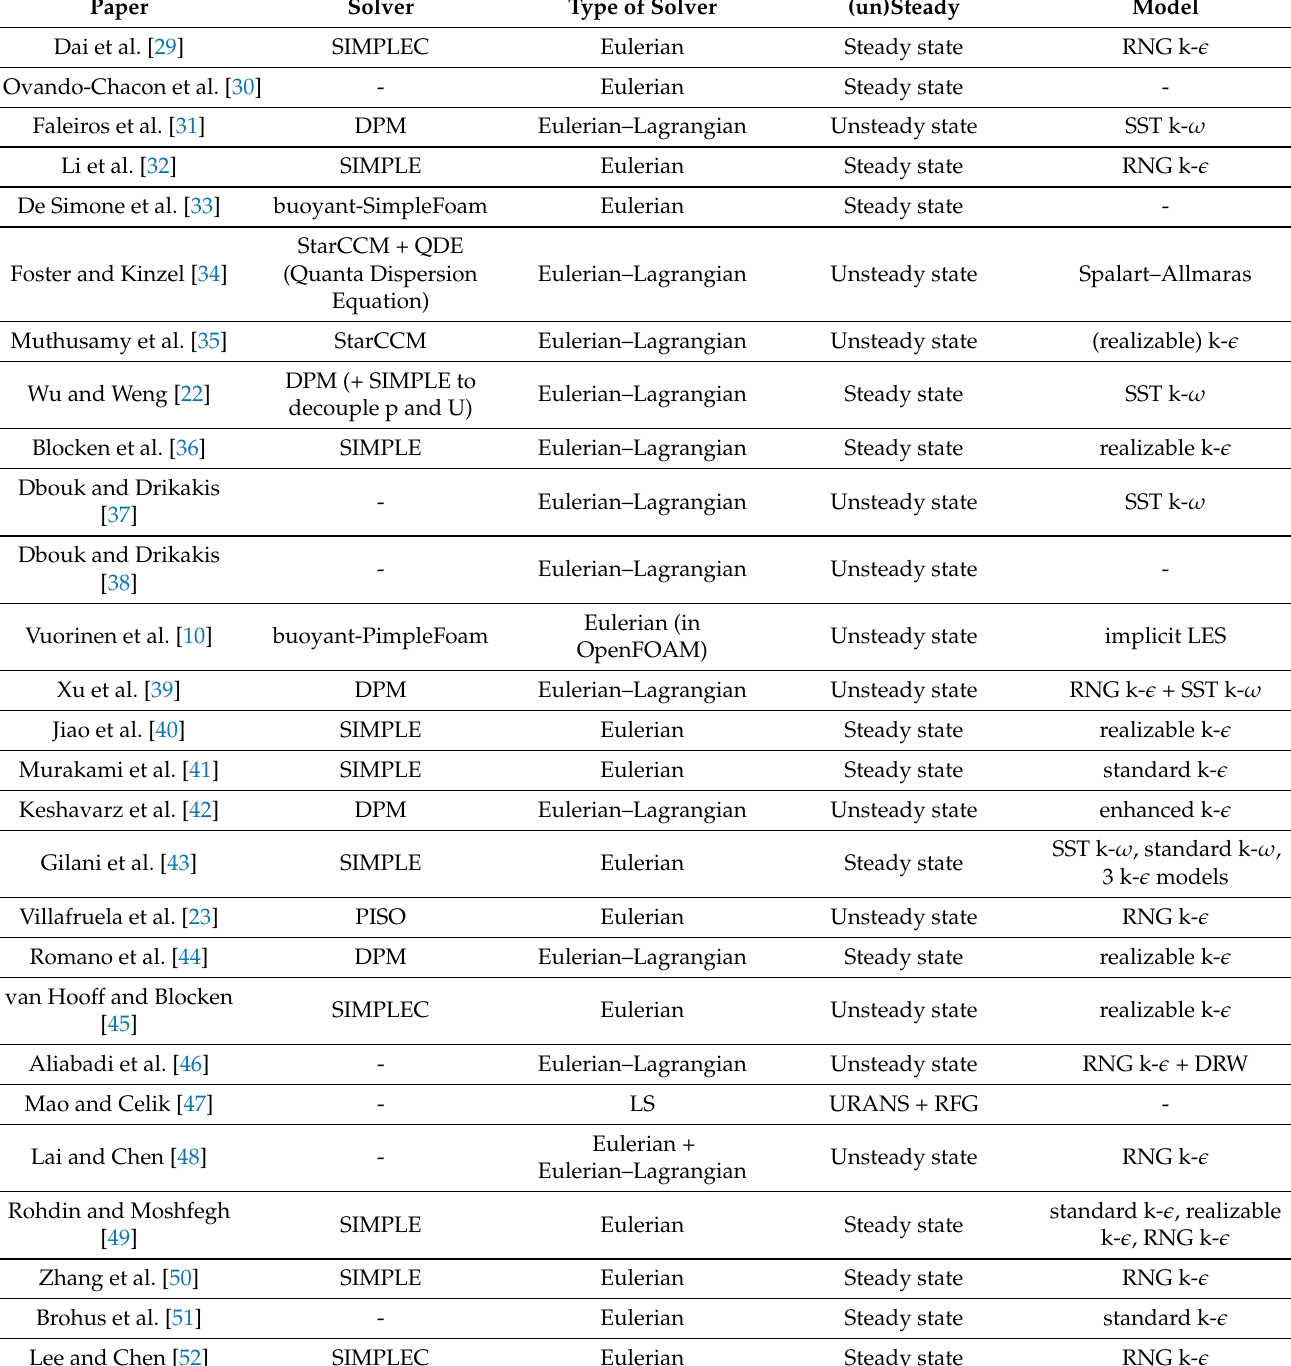
Table 2. Summary of the CFD solvers and methods used in the selected